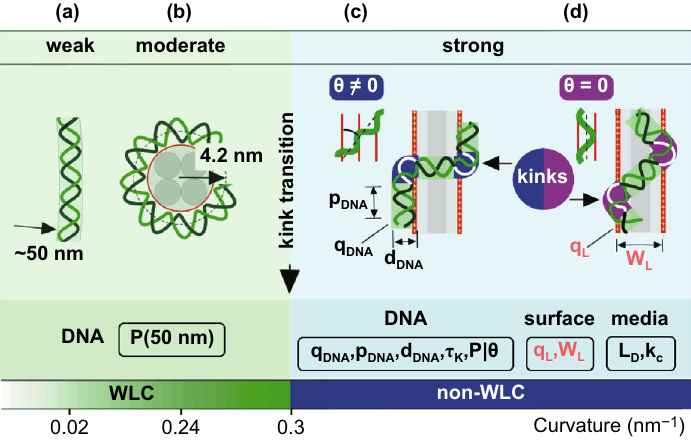
Fig. 6 The comparison (approximately in the scale) of the undercritical weak ( a ) and moderate ( b ) DNA bending described by the WLC or similar linear elastic models and the strong nonlinear bending in the kinked non‑WLC DNA conformations on a 1D periodically charged surface ( c, d ). a thermal fluctuations in DNA shapes. b DNA wrapped in nucleosomes [58]. c, d hypothetical models of DNA kinking at θ ≠ 0 (c) and θ = 0 (d). At the bottom, the parameters involved in the consideration and specified on the figure and in the text are listed (P is the only parameter in case of the WLC